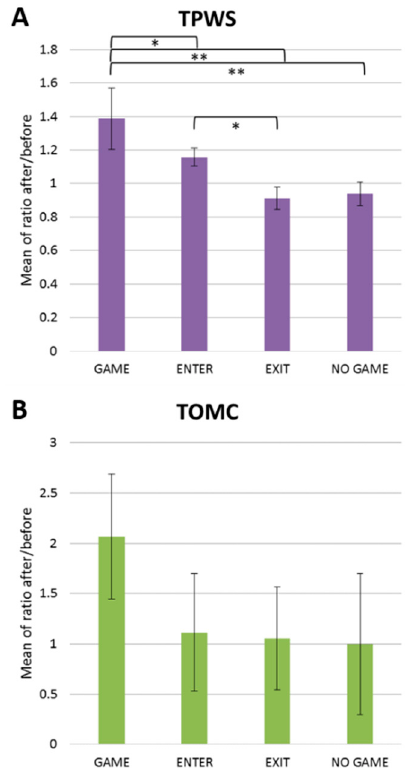
Figure 2. The average values of after / before match ratios referring to ( A ) total proteins (TPWS) and ( B ) total observed metabolite concentrations (TOMC) .